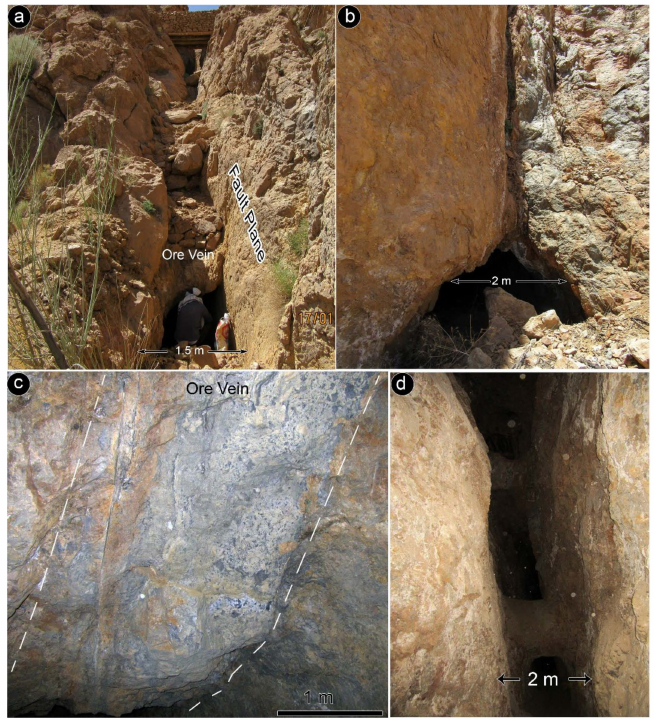
Figure 5. The outcrop of sulfide ore veins in extensional strike-slip faults on the surface ( a , b ) and underground tunnels ( c , d